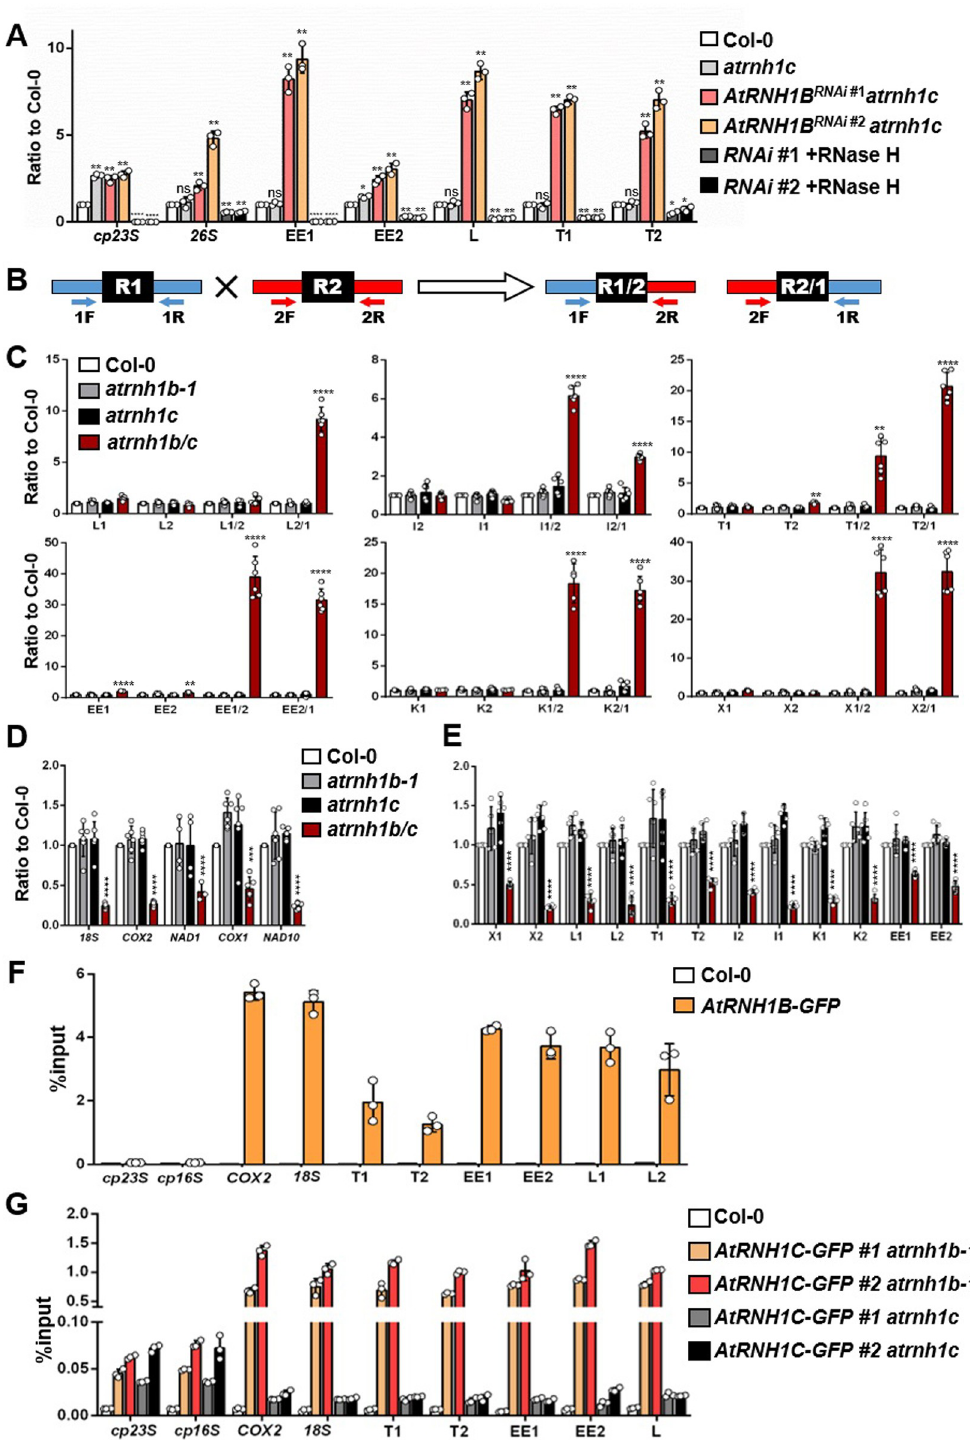
Fig 7. Atrnh1b/c exhibits increased R-loop formation and HR, leading to reduced mtDNA levels. (A) DRIP-qPCR of siliques from Col-0, atrnh1c , and AtRNH1B RNAi atrnh1c lines ( RNAi #1 and # 2 ), including the chloroplast gene 23S ( cp23S ) and mitochondrial gene 26S and repeats EE1, EE2, L, and T. Data are normalized to Col-0 and shown as mean values ± SD; circles show the original data from 3 replicates. The cp23S locus was used as a positive control. RNAi #1/ #2 +RNase H1 were used as negative controls. One-way ANOVA compared to Col-0 for each primer. ns, no significance; � , p < 0.05; ��